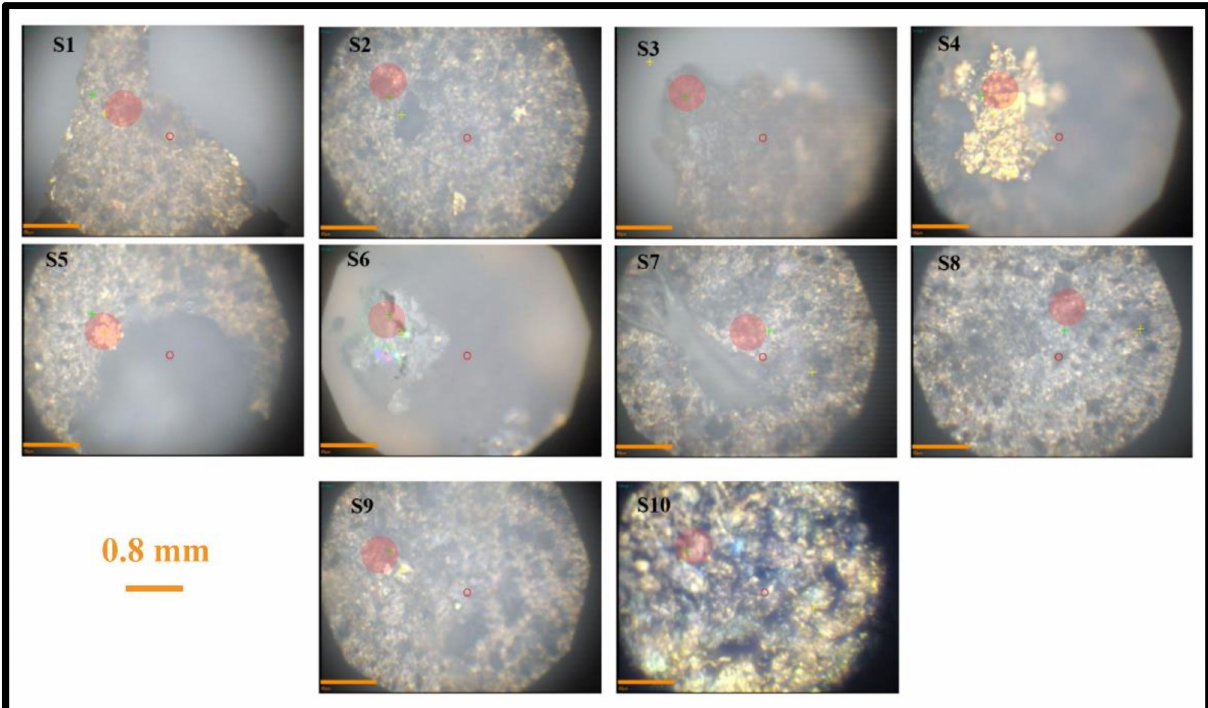
Figure 3. The collection of optical images from the investigated sectors S1–S10 (Figure 1) of the specimen N. 01.1622 performed with the 20 × objective. The transparent red circles highlight the areas investigated.